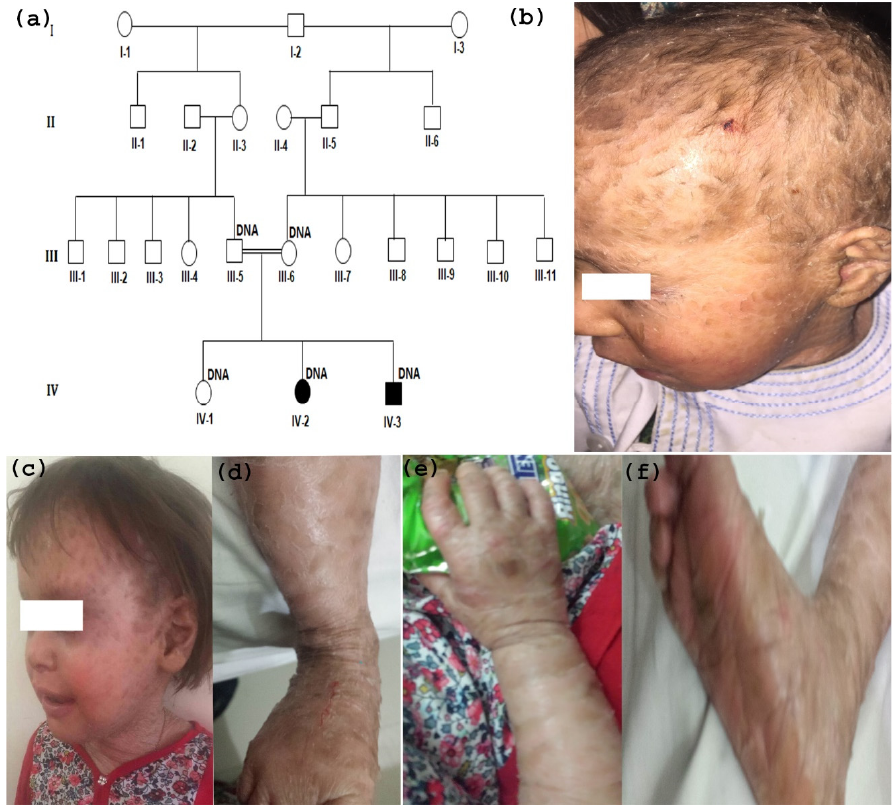
Figure 1. ( a ) Pedigree of a consanguineous family with lamellar ichthyosis. Affected and unaffected individuals are shown by filled and unfilled symbols, respectively. The individual numbers denoted by “DNA” indicate the sample available for this study. A double line uniting two members indicates consanguineous marriage. ( b , c ) Clinical features of LI patients showing thick large scales on their body including face, hyperkeratosis dry and sparse hair with scanty eyebrows, ( d – f ) both the patients showing keratoderma on their palms and soles and finer scales on legs and arm.